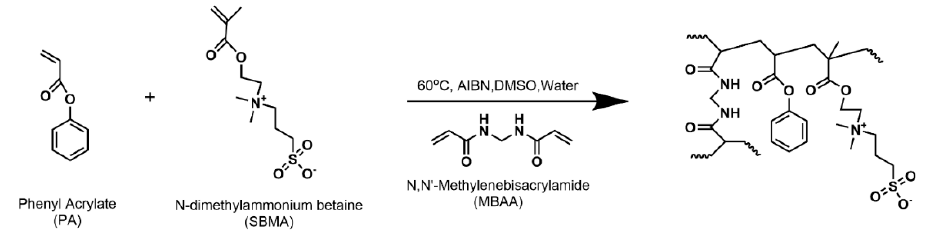
Figure 1. Synthetic scheme of PA − SBMA membrane.